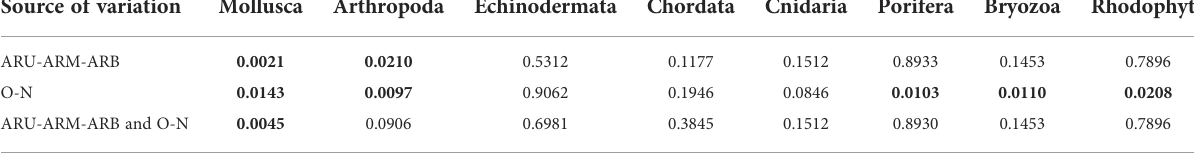
Bold P -values indicate signi fi cant effects